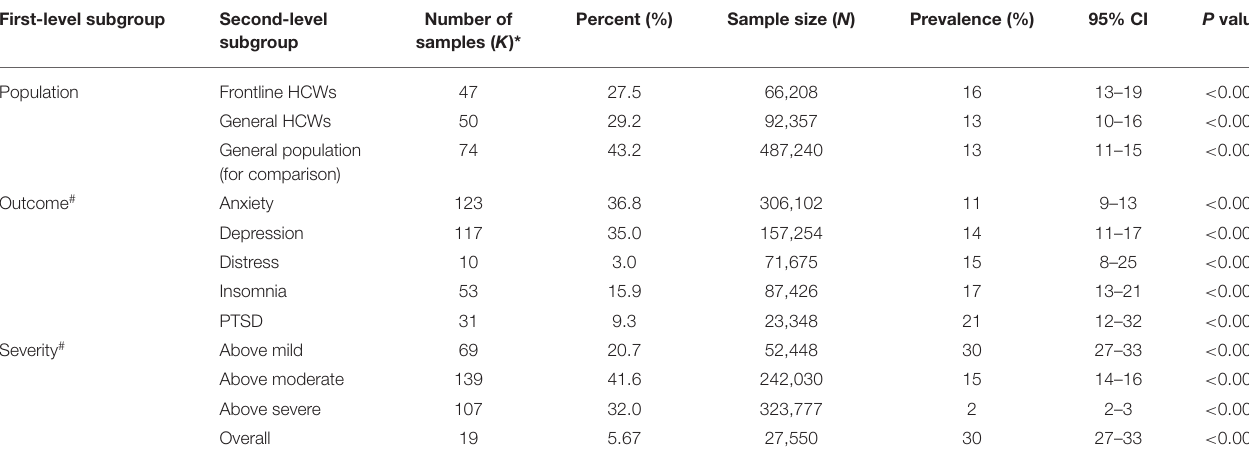
TABLE 2 | The pooled prevalence rates of mental health symptoms by subgroups of population, outcome, and severity. First-level